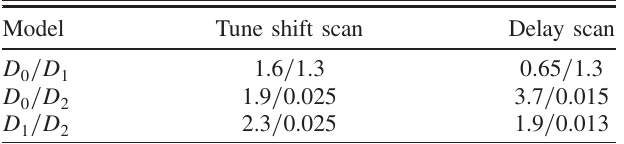
TABLE II. Comparison of the diffusion coefficients from